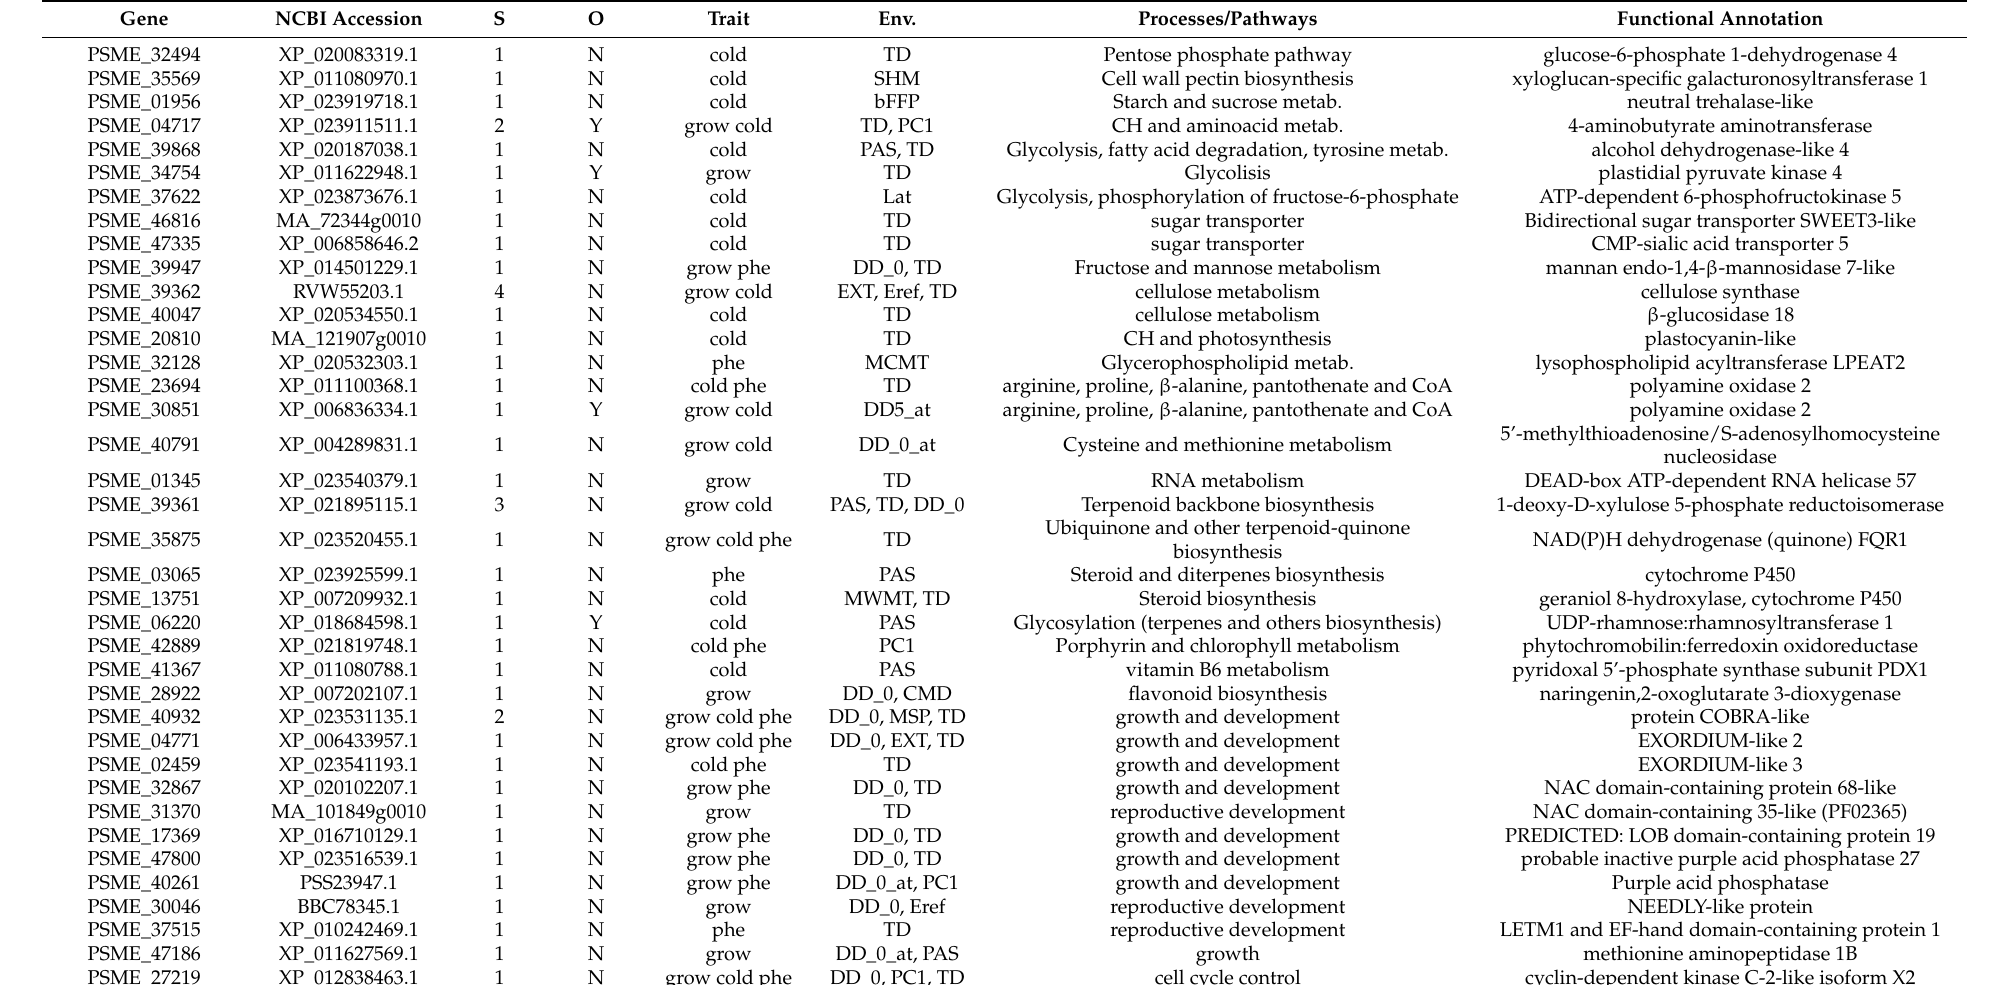
Table 2. Functional characterization of genes associated with cold adaptation in coastal